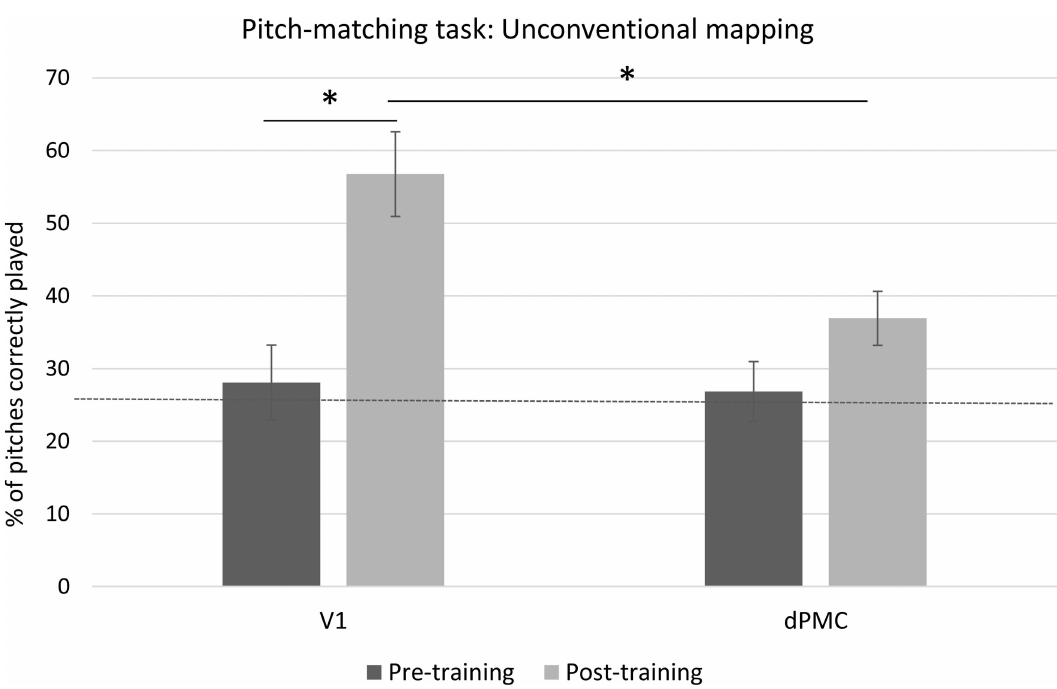
Fig 7. Results of the training phase of the study of Experiment 2. Graph represents the percentageof pitches correctly played plotted across blocks of trials (Baseline, Block 1, Block 2 and Block 3) for the dPMC and the V1 groups. As indicatedby asterisks, TMS over the dPMC significantly reduced participants’ accuracy in Block 2 and 3 compared to the V1 stimulation.Error bars represent ± 1